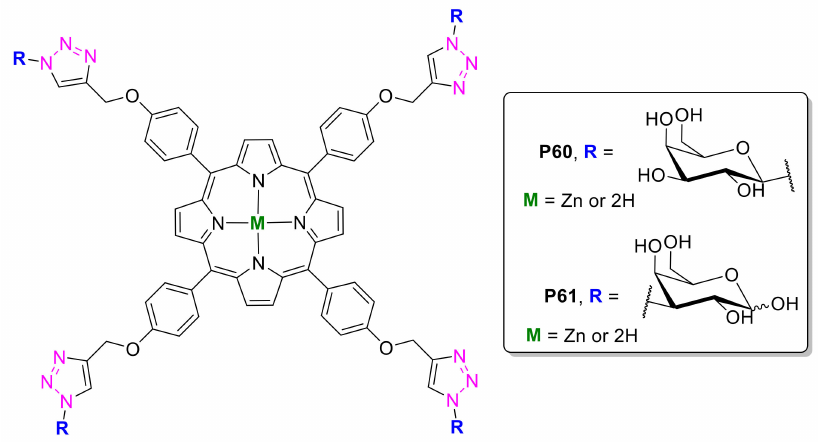
Figure 6. Structures of porphyrin–carbohydrate conjugates P60 and P61